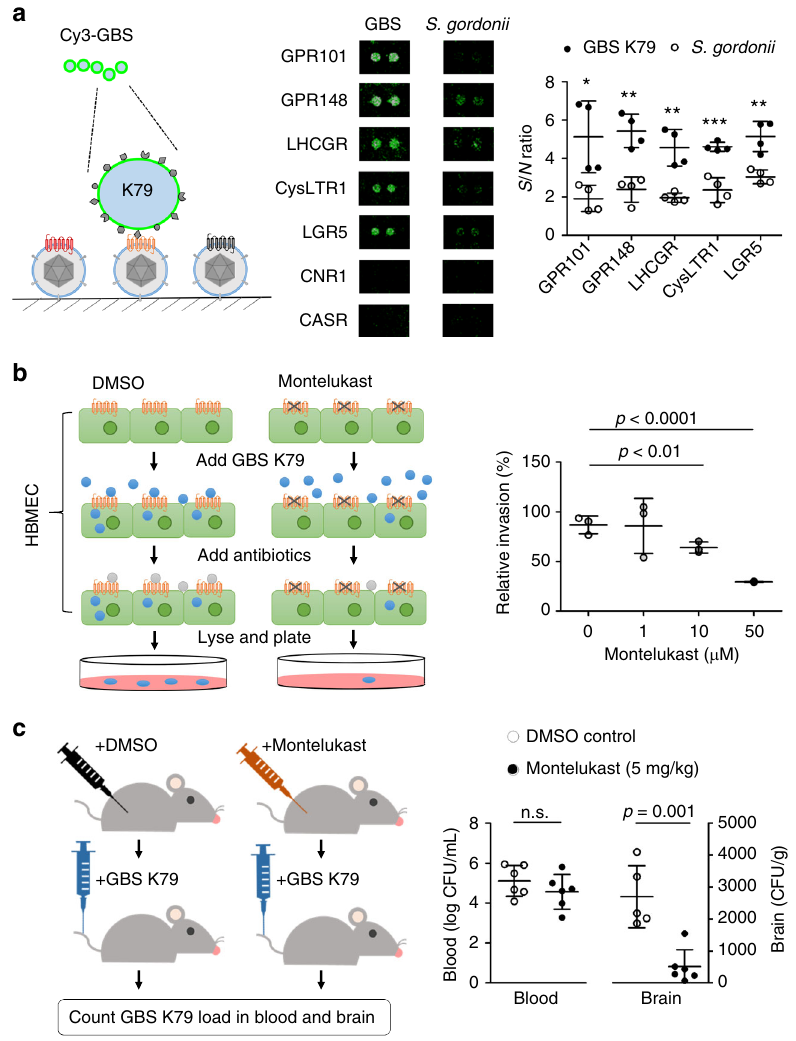
Fig. 5 Discovery and validation of a new GPCR receptor for GBS. a Five VirD-GPCRs were identi fi ed as potential candidate receptors. A clinical strain K79 of GBS was Cy3-labeled and probed to a VirD-GPCR array. In parallel, S. gondonii was used as a non-pathogenic negative control (middle). CNR1 and CASR were not bound by either GBS or S. gondonii . Quantitative analysis of the binding signals from the two bacteria identi fi ed fi ve GBS-speci fi c GPCRs (right). n = 2, biologically independent samples. b In vitro validation of CysLTR1. Human brain microvascular endothelial cells (HBMEC) were pretreated with Montelukast to block CysLTR1, followed by incubation with GBS. After washes, antibiotics were added to kill free bacteria and HBMEC were lysed and plated onto blood agar plates. After overnight incubation, numbers of GBS colonies were counted. As compared with the DMSO-treated negative control, Montelukast showed a dose-dependent inhibition of GBS invasion into HBMEC. n = 5, biologically independent samples. c In vivo validation of CysLTR1. A group of mice was each intraperitoneally administered Montelukast ( n = 6) or DMSO ( n = 5). After 2 h each mouse received 1 × 10 8 CFU of GBS (K79) via the tail vein injection. One hour later, blood and homogenized brains were collected and plated for bacterial counts. Using the same colony formation method, administration of Montelukast reduced GBS brain infection in the mice by an average of 81% as compared to the DMSO controls (right). No signi fi cant differences in the levels of GBS counts were observed in the blood between the two groups. Data were analyzed with two-tailed Student ’ s t -test whereas * P < 0.05, ** P < 0.01, and *** P <